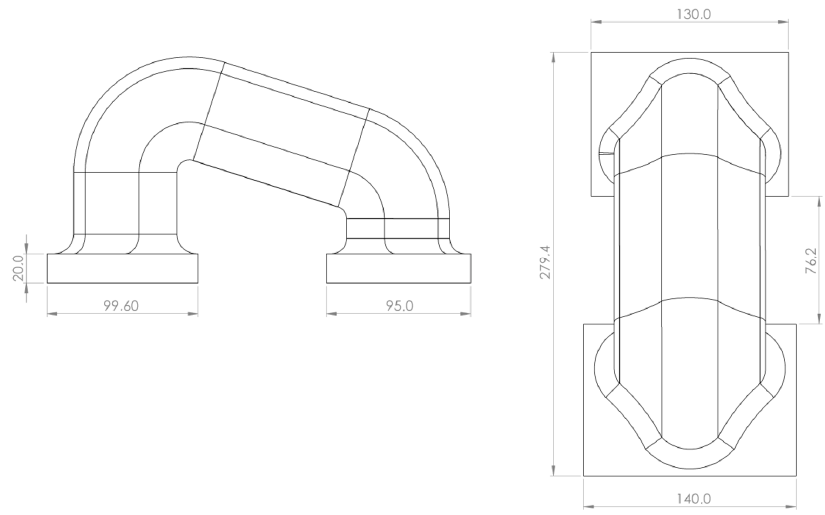
Figure 18. The basic dimensions of the unit for fastening the wagon.